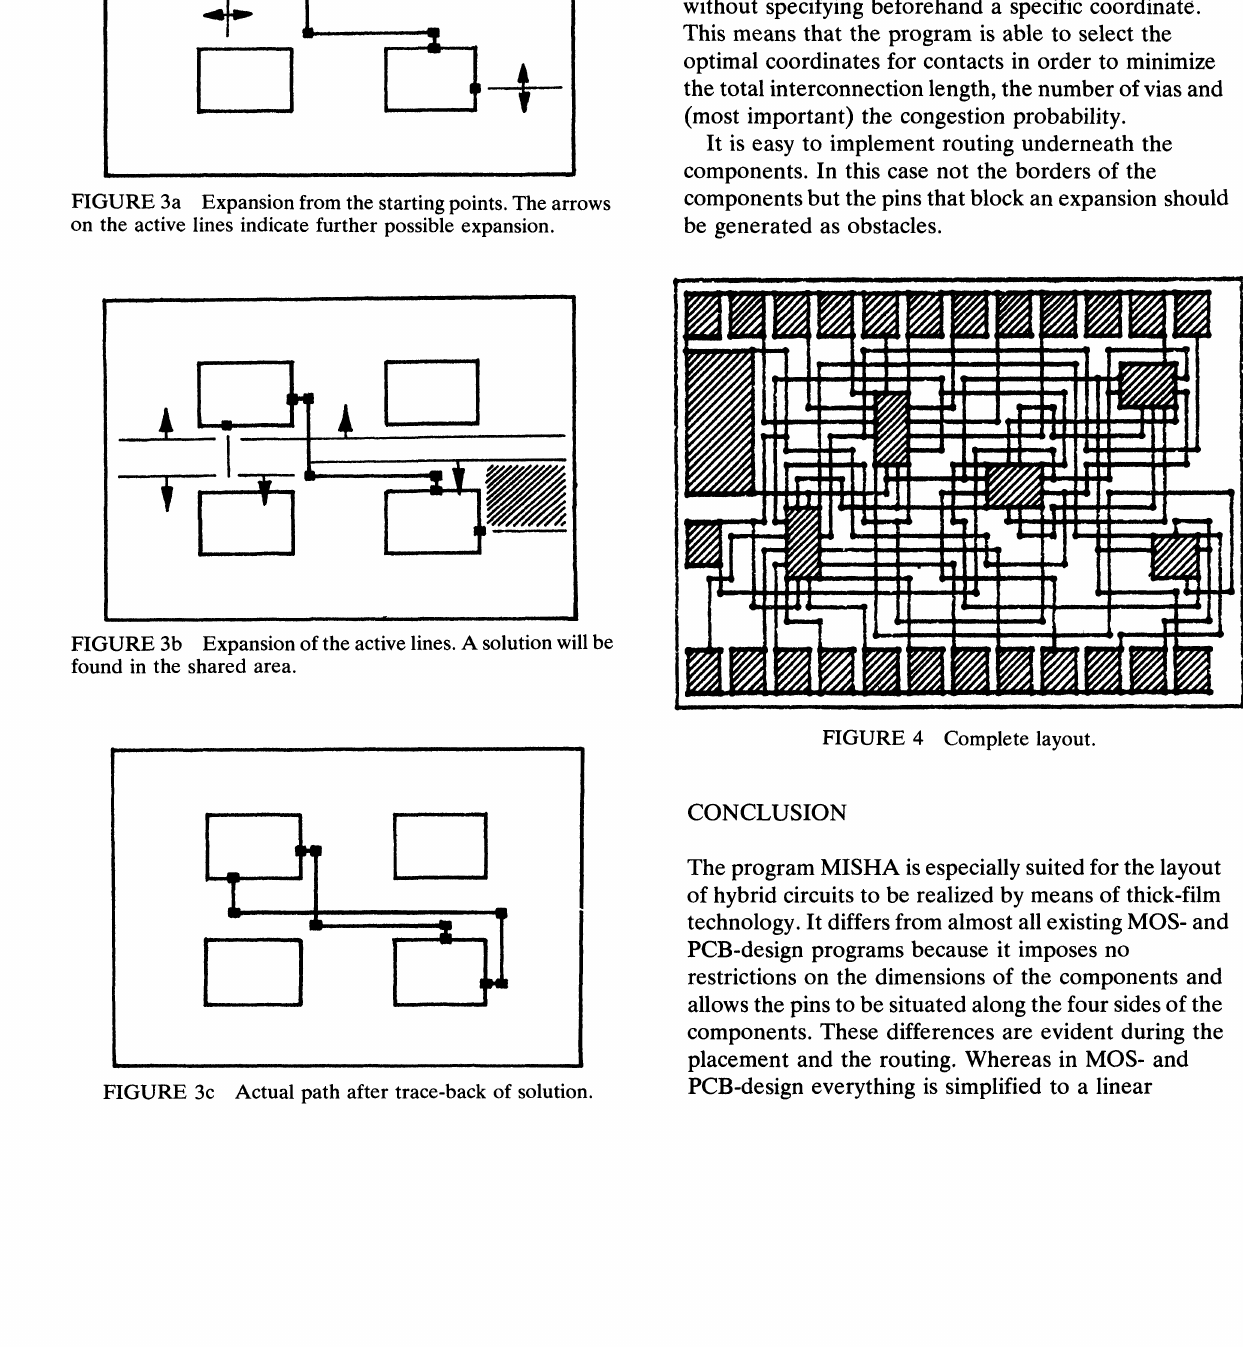
FIGURE 3c Actual path after trace-back of